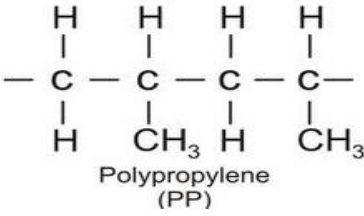
Figure 3. Chemical structure of PP.